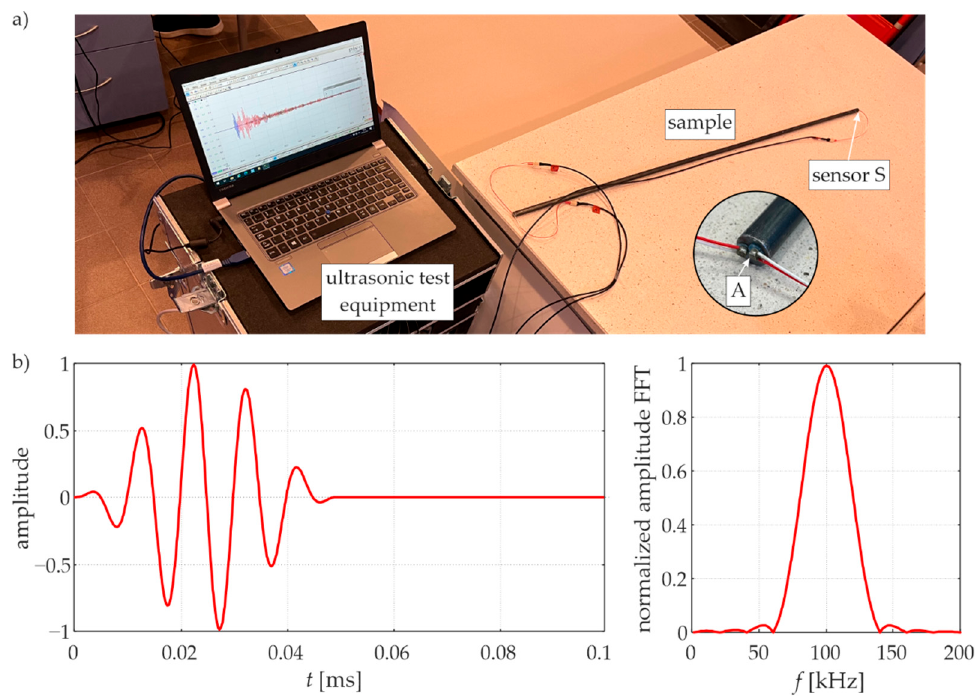
Figure 5. ( a ) Experimental setup. ( b ) Five-cycle sine wave packet with the carrier frequency of 100 kHz (time-domain signal and frequency spectrum).